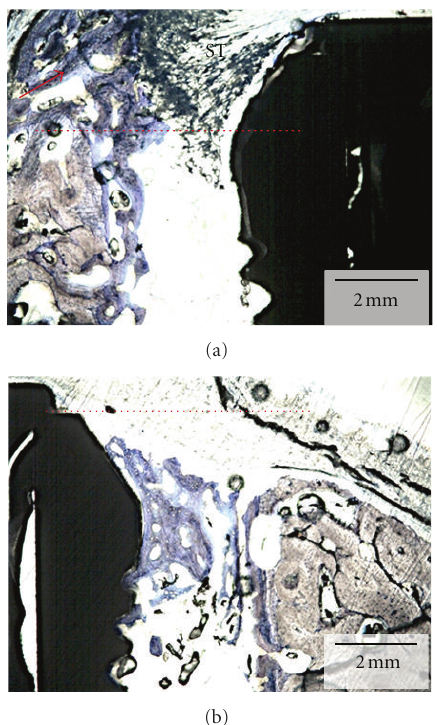
Figure 5: (a) Optical micrograph depicting the lingual aspect of the section presented in the red box in Figure 3. The dashed red line represents the implant cervical level (immediately below the implant cover screw). New bone formation through the course of six weeks resulted in higher levels than at the time of placement (red arrow). The soft tissue (ST) limited migration likely occurred due to membrane movement during suture where it partially bent in the apical direction allowing tissue migration. (b) Optical micrograph depicting the buccal aspect of the section presented in the blue box in Figure 4. The dashed red line represents the implant cervical level (immediately below the implant cover screw). New bone formation through the course of six weeks resulted in bone height maintenance and closure of the gap between implant surface and socket wall. For this section, no soft tissue apical migration